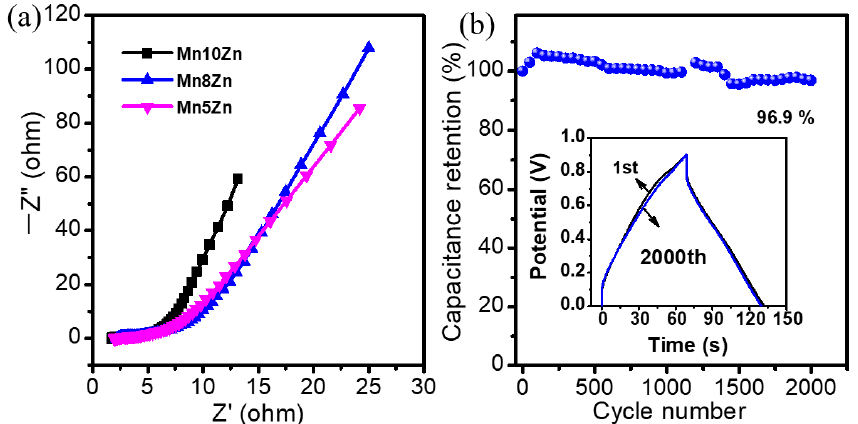
Figure 6. ( a ) Nyquist plot of the impedance of Zn-doped MnO 2 materials; ( b ) cyclic performance of Mn10Zn at a constant current of 0.2 A·g − 1 , the inserted image of ( b ) is the first and 2000th GCD patterns of Mn10Zn.